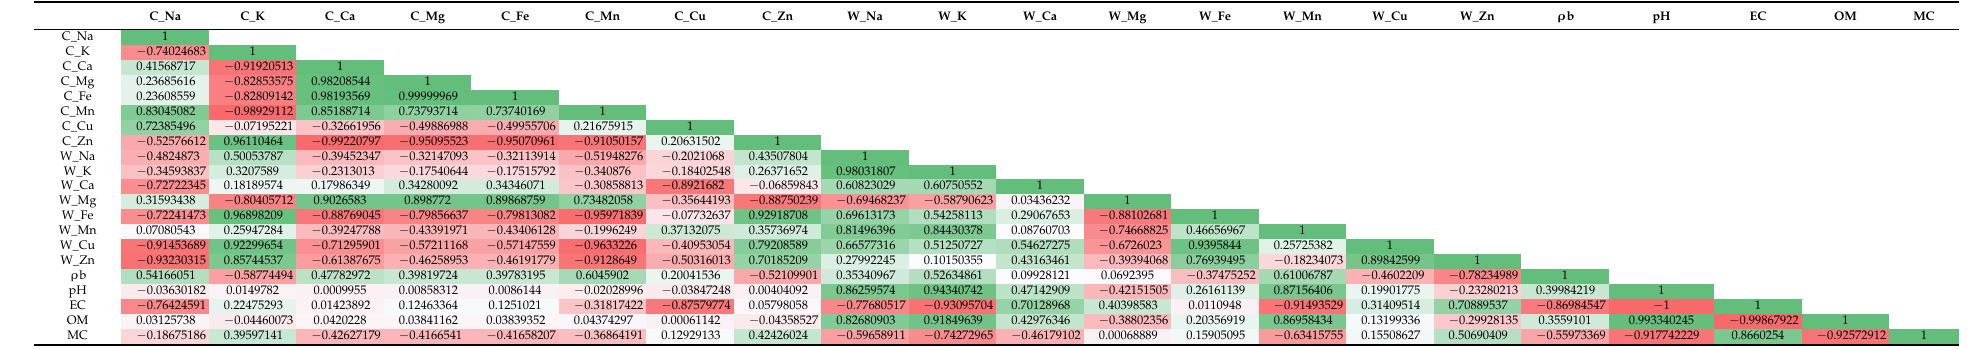
Table A5. Correlation coefficients between elemental composition nutrient content, water extractable nutrient content and physical and chemical properties of PP.